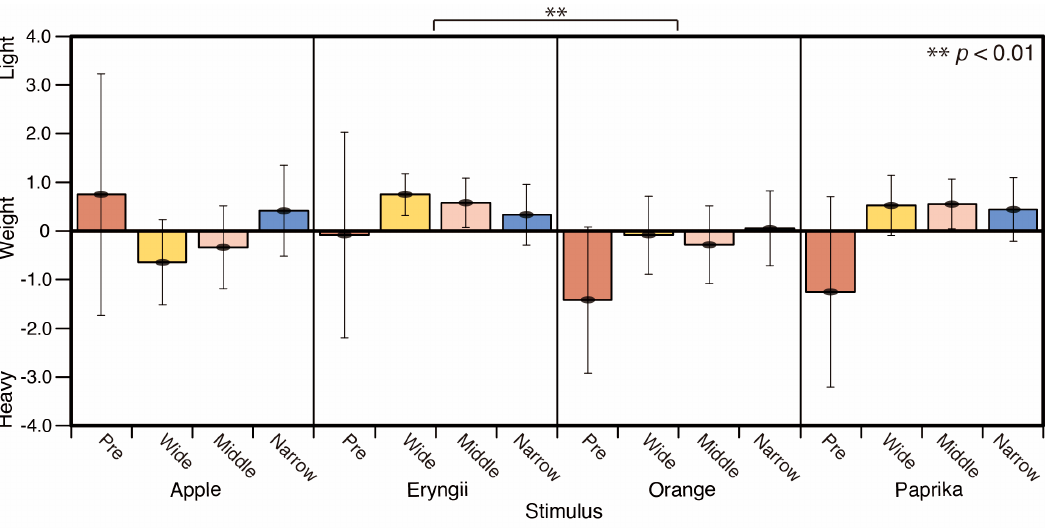
Figure 12. Weight scores.